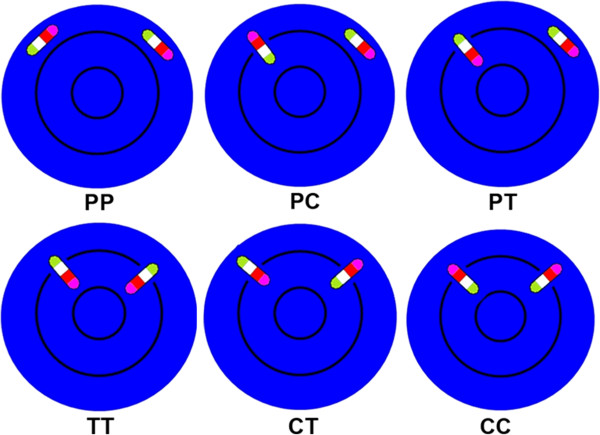
Cartoon illustration of different possibilities of chromosome 11 orientation pairs in the nucleus. The representative chromosome is composed of four differently colored segments; green segments represent telomeric ends, magenta segments centromeric ends, proximal and distal (not measured) interstitial segments are shown in cyan blue and red, respectively. The nucleus is illustrated in blue; the black circles divide the nucleus into central, intermediate and peripheral regions (PP = both homologs parallel to the nuclear periphery, PC/PT = one homolog is located in parallel to the periphery, while the other is oriented with its centromeric (red)/telomeric (green) end towards the nuclear periphery, TT = both homologs point with their telomeric (green) ends towards the periphery, CT = one homolog with its centromeric (red) end and the other homolog with its telomeric (green) end pointing towards the nuclear periphery, CC = both homologs point with their centromeric (red) ends towards the nuclear periphery, ). PP, PC and PT in the first row of Figure 2 are observed most frequently.